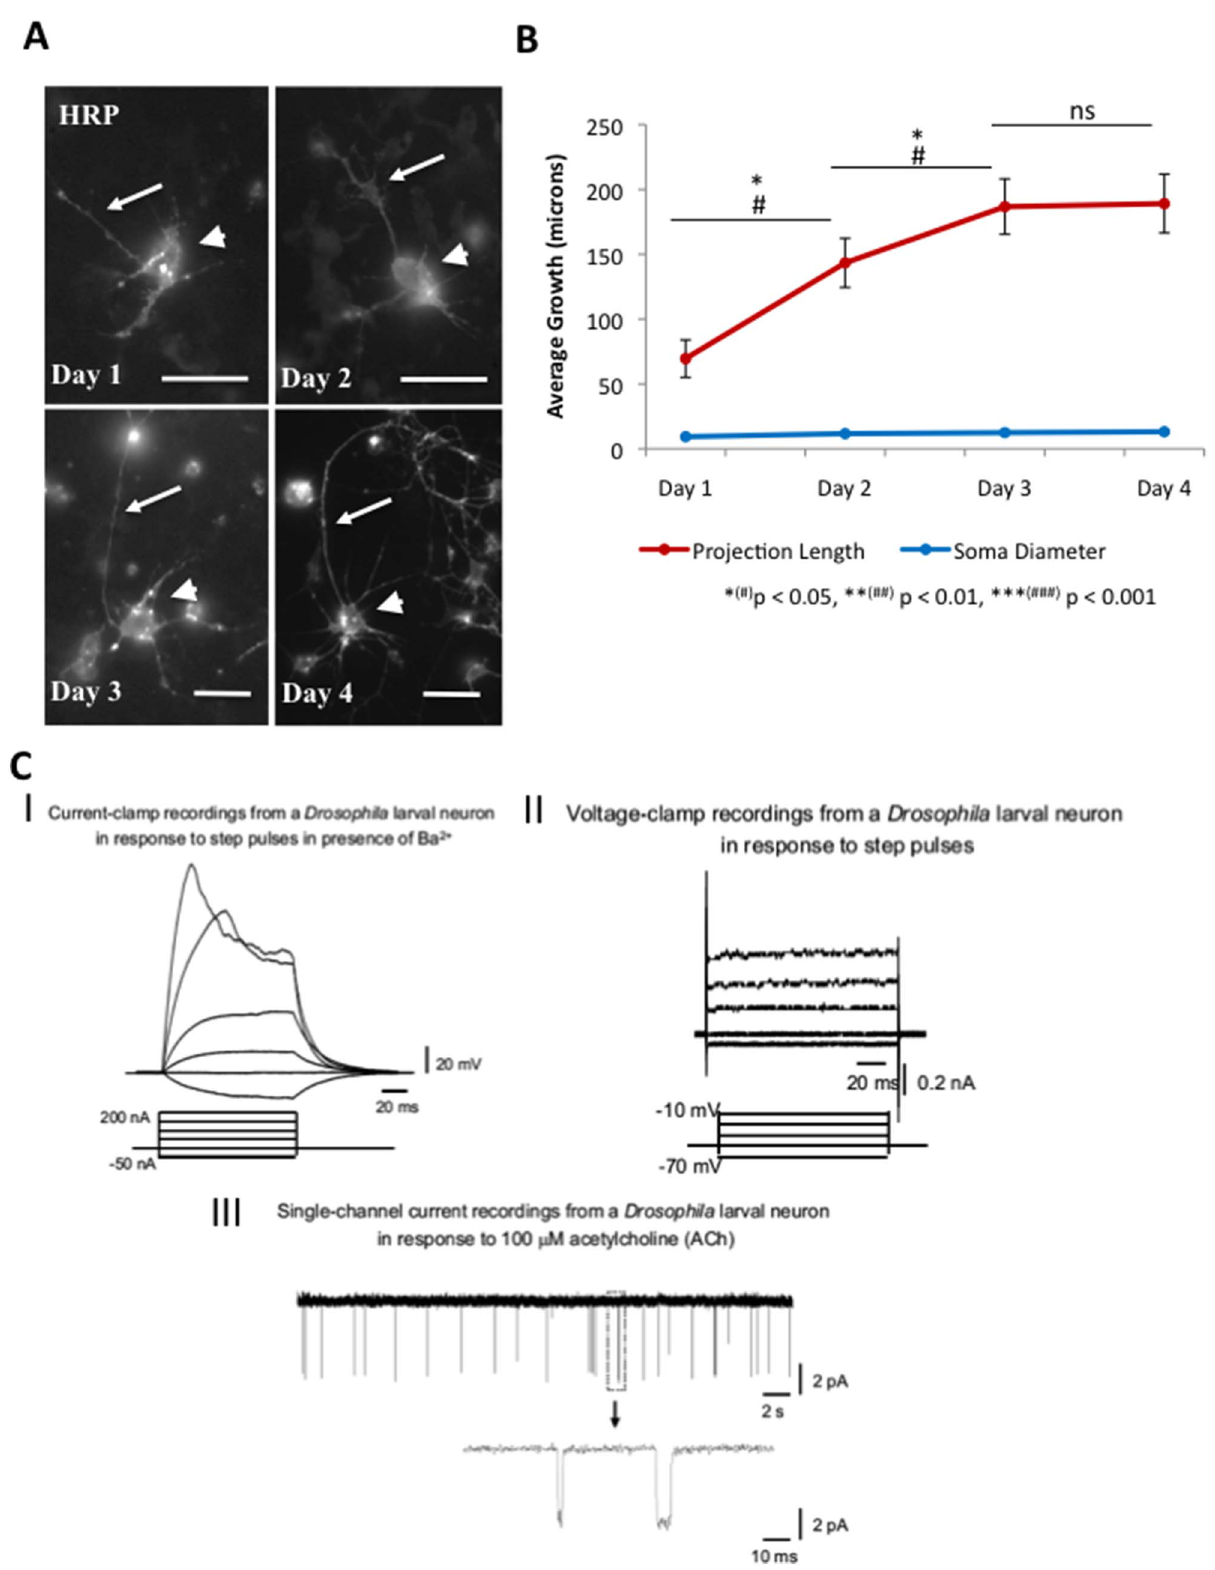
Figure 1. Primary Drosophila larval neurons are healthy and functional. Under our conditions, primary neurons generated from larval brains grew and retained their functional activity over several days. ( A ) Significantly longer neuronal projections were observed at day 2, day 3 and day 4 as assayed by both phase contrast (data not shown) and HRP staining. Neurons at day 1 and 2 were imaged at 100X, while neurons at day 3 and 4 were imaged at 60X. Cell body = arrowhead, neurite projection = arrow. Bar=10 microns ( B ) Quantification of neuronal projection lengths at day 1 to day